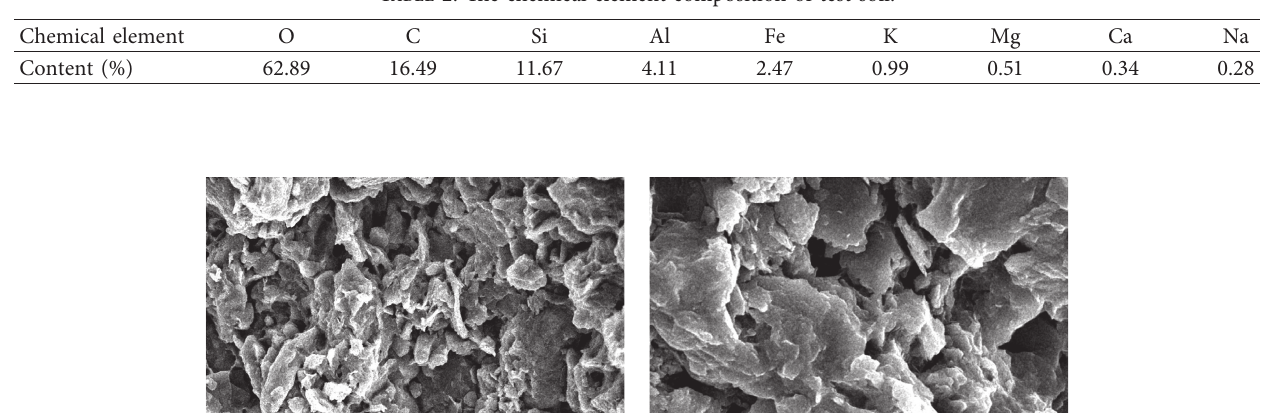
Figure 11: The grain size distribution of test soil. Table 2: The chemical element composition of test soil.